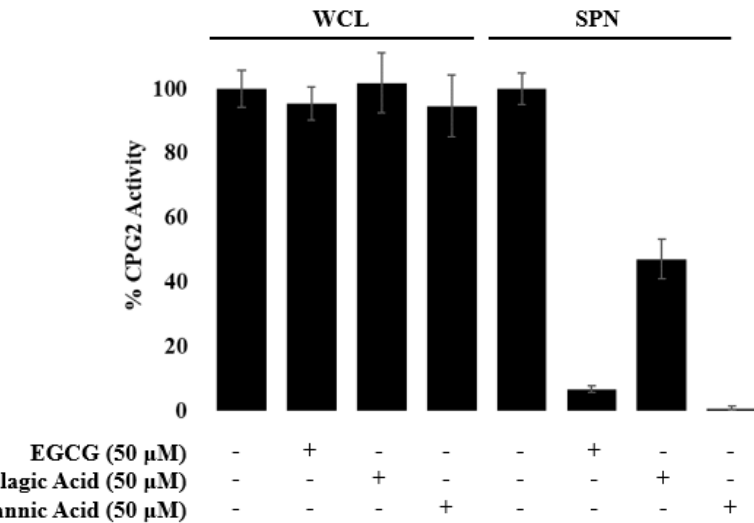
Figure 7. The compounds EGCG, ellagic acid, and tannic acid were screened for their ability to inhibit the production of CPG2 in whole-cell lysate (WCL) and the secretion of the enzyme into the supernatant (SPN). None of the compounds had a significant effect on the activity of CPG2 in lysate, indicating that the expression of CPG2 is not inhibited by these compounds, while still inhibiting the secretion of CPG2 through the T3SS.